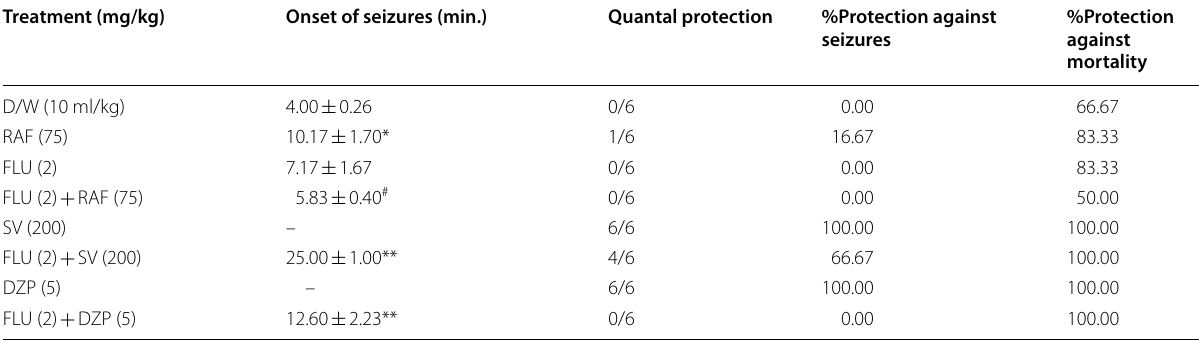
D/W, distilled water; RAF, residual aqueous fraction of Ipomoea asarifolia ; FLU, flumazenil; DZP, diazepam; SV, sodium valproate Values are presented as mean SEM ± * P < 0.05; ** P < 0.01 as compared to D/W group # P < 0.05 as compared to RAF group—One-way ANOVA followed by Tukey post hoc test, n